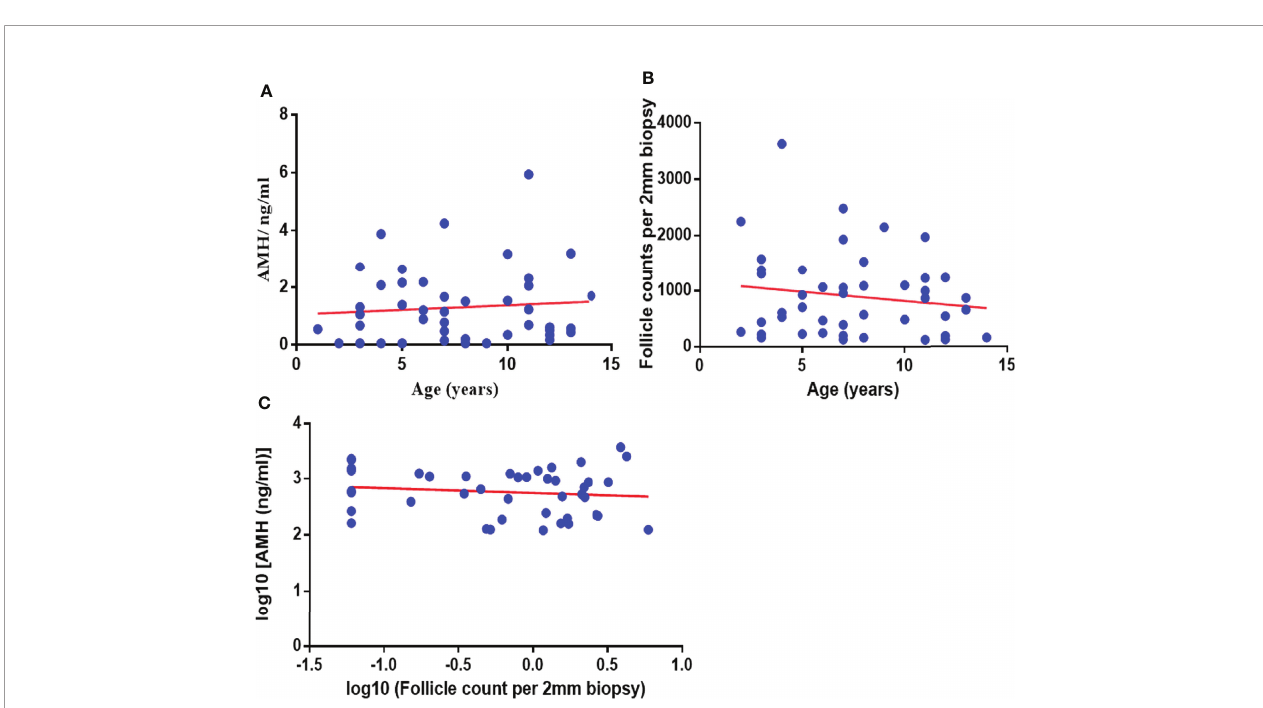
FIGURE 4 | Correlation analysis and linear regression analysis between Age and AMH (A) (n = 45, r = 0.084, P = 0.585), between age and follicle count per 2-mm biopsy (B) (n = 45, r = − 0.128, P = 0.403), between log10 (follicle count per 2-mm biopsy) and log10 (AMH) (C) (n = 45, r = − 0.118, P = 0.456). AMH, anti-Müllerian hormone.